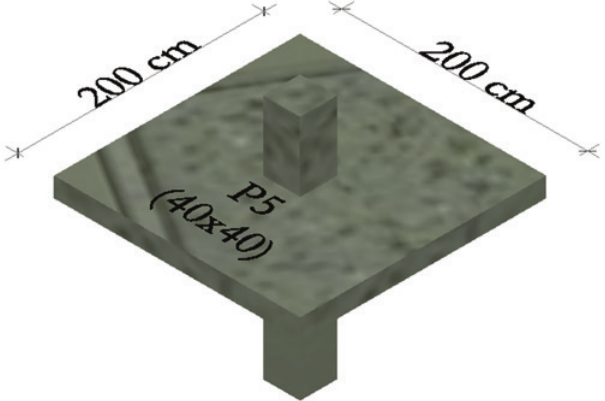
Região da laje modelada para obtenção da carga de